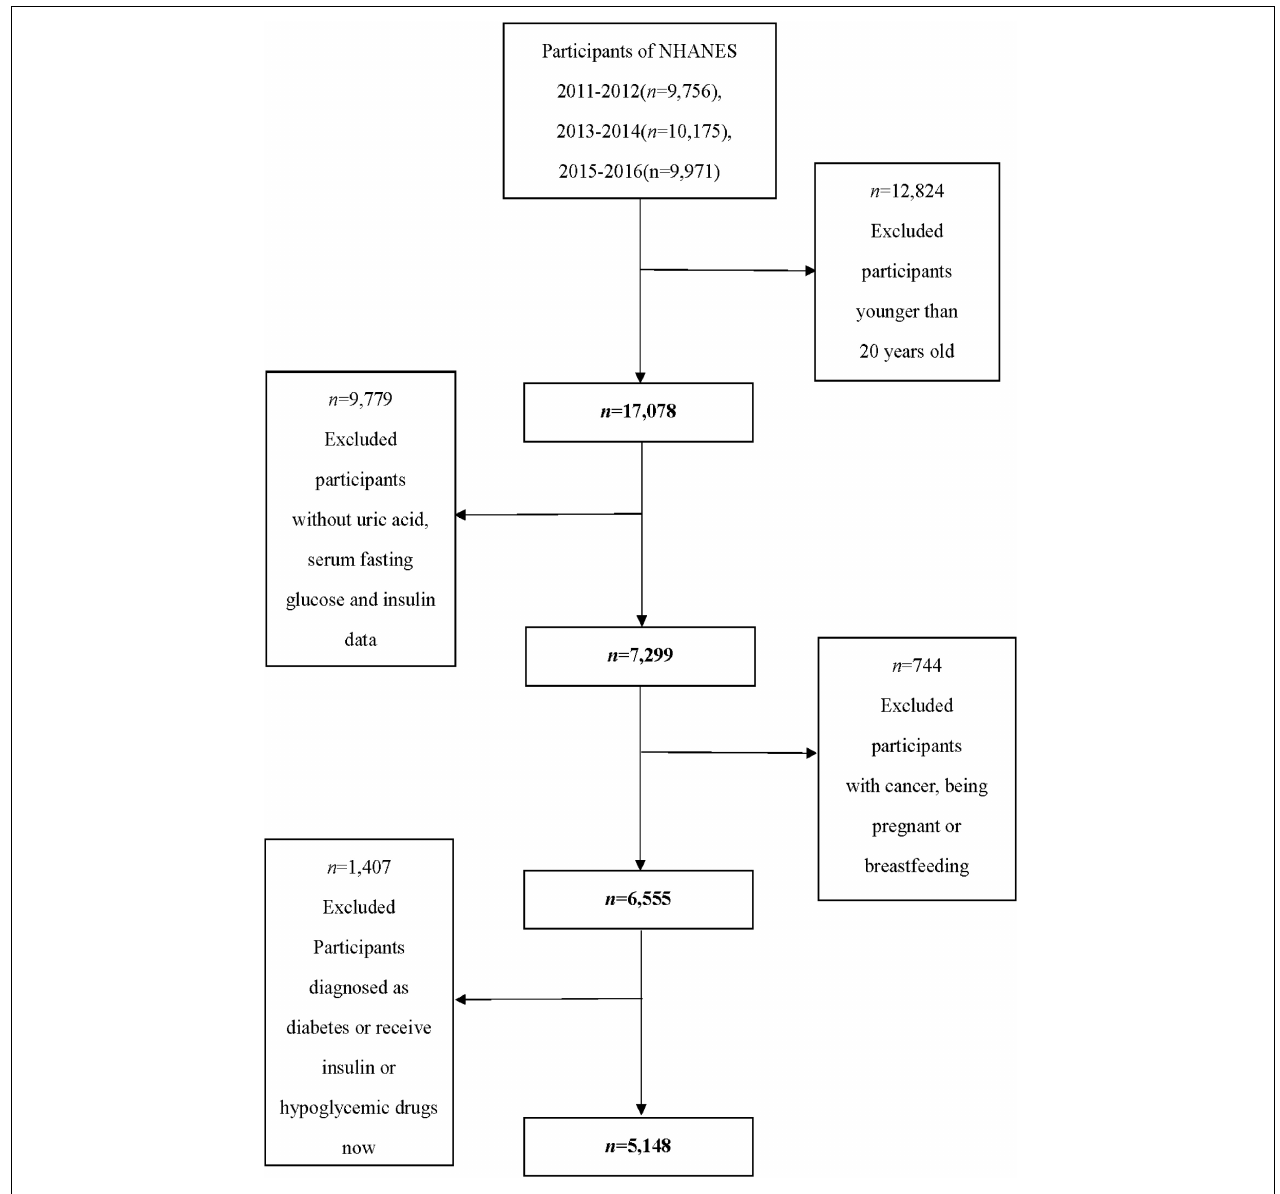
FIGURE 1 | Flow chart of the screening process for the selection of eligible